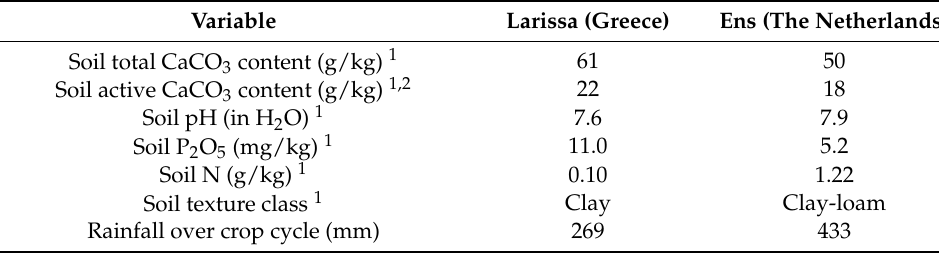
Table 1. Soil variables and rainfall of two white lupin test locations.